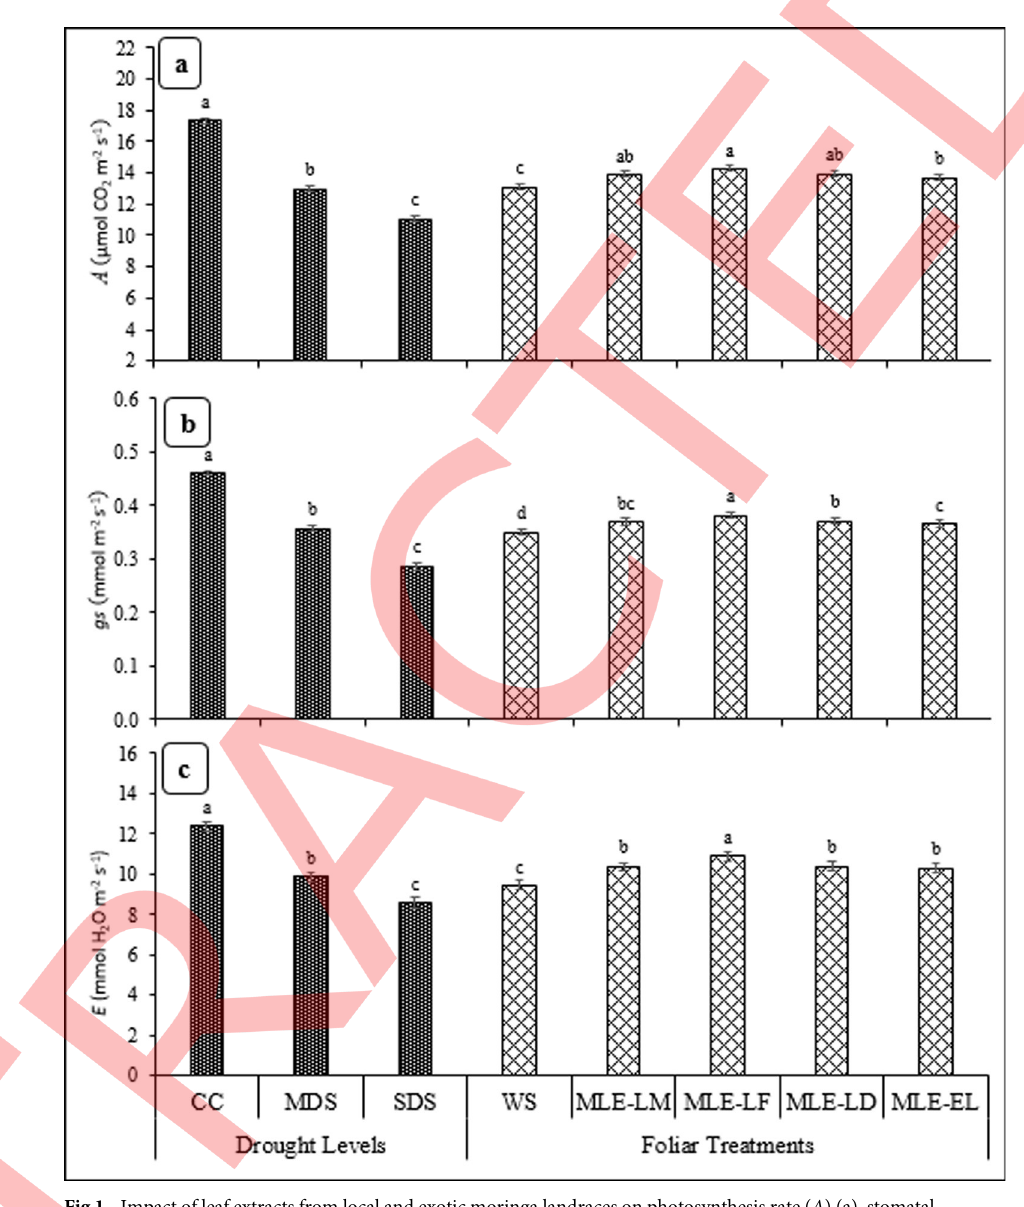
Fig 1. Impact of leaf extracts from local and exotic moringa landraces on photosynthesis rate ( A ) (a), stomatal conductance to water ( gs ) (b) and respiration rate ( E ) of rice cultivated under normal and drought-stressed environments (n =